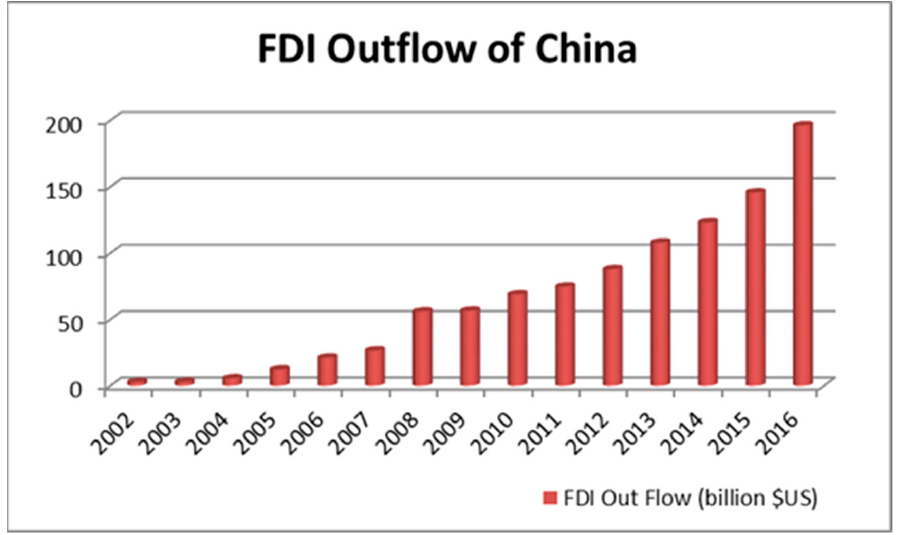
Figure 1. Chinese OFDI from 2002 to 2016.